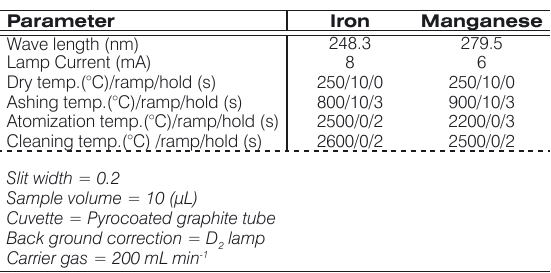
Table 1. Measurement conditions for electrothermal atomization